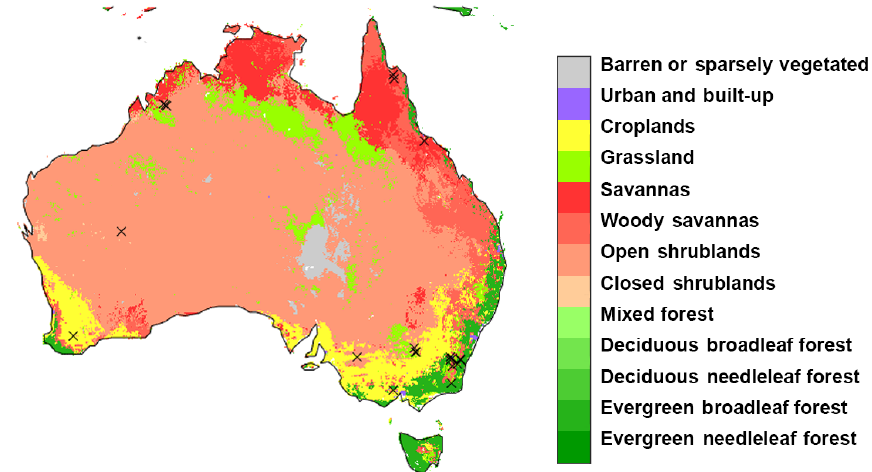
Figure 2. MCD12C1 land cover type map for Australia (Hansen et al., 2000). The locations of 23 valid observed degree of curing (DOC) sites are marked with